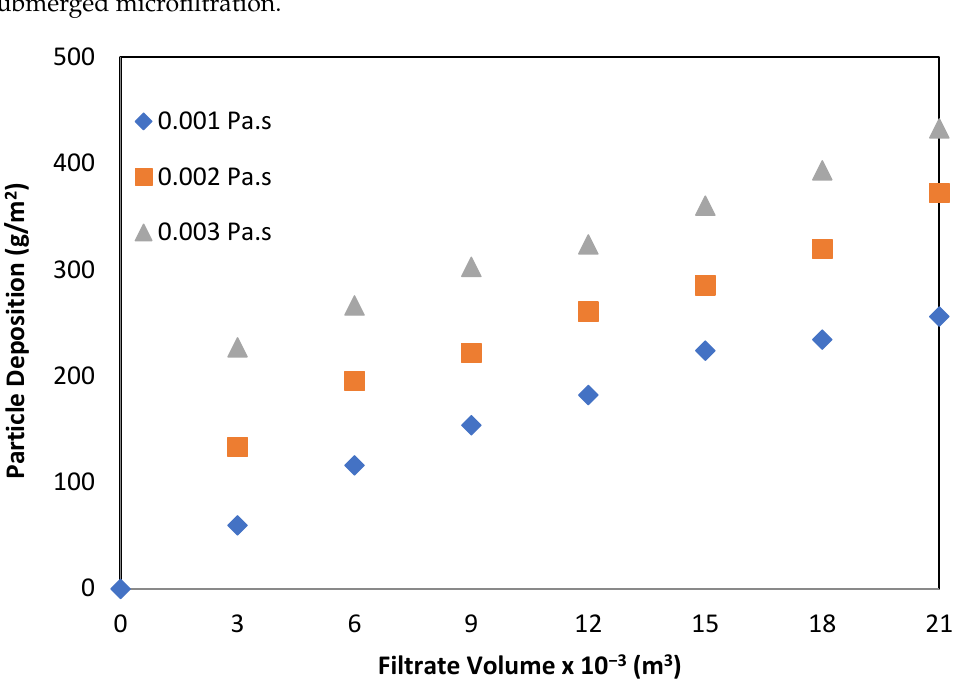
Figure 4. Effect of viscosity on particle deposition on membrane surface at different concentrations of viscosity with air flow rate of 1.2 m 3 /m 2 /h.